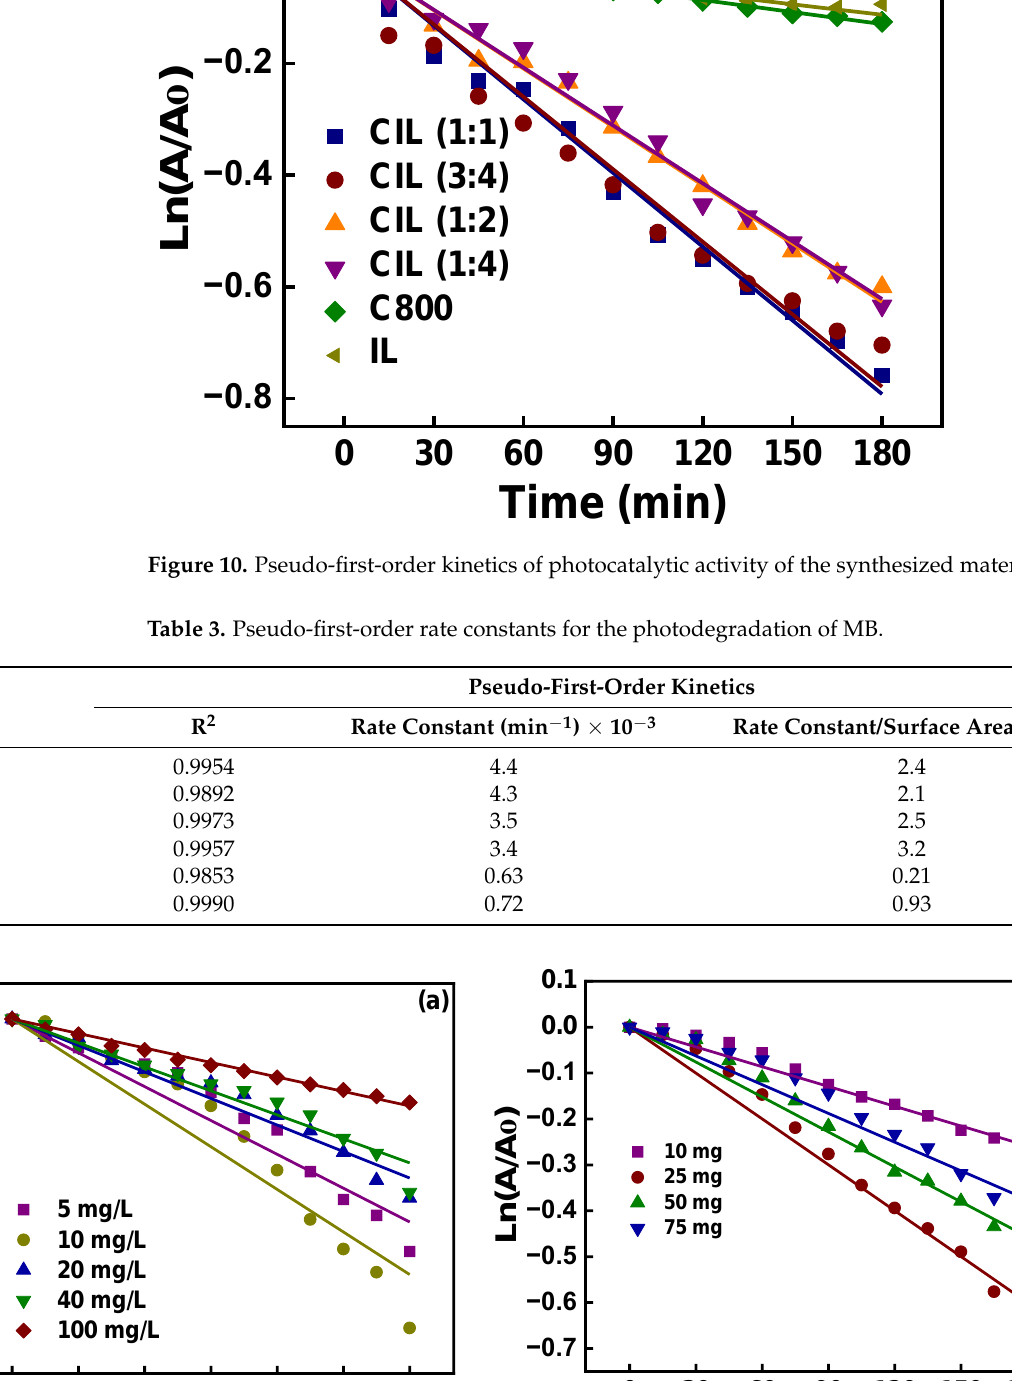
Figure 10. Pseudo-first-order kinetics of photocatalytic activity of the synthesized materials. Table 3. Pseudo-first-order rate constants for the photodegradation of MB.